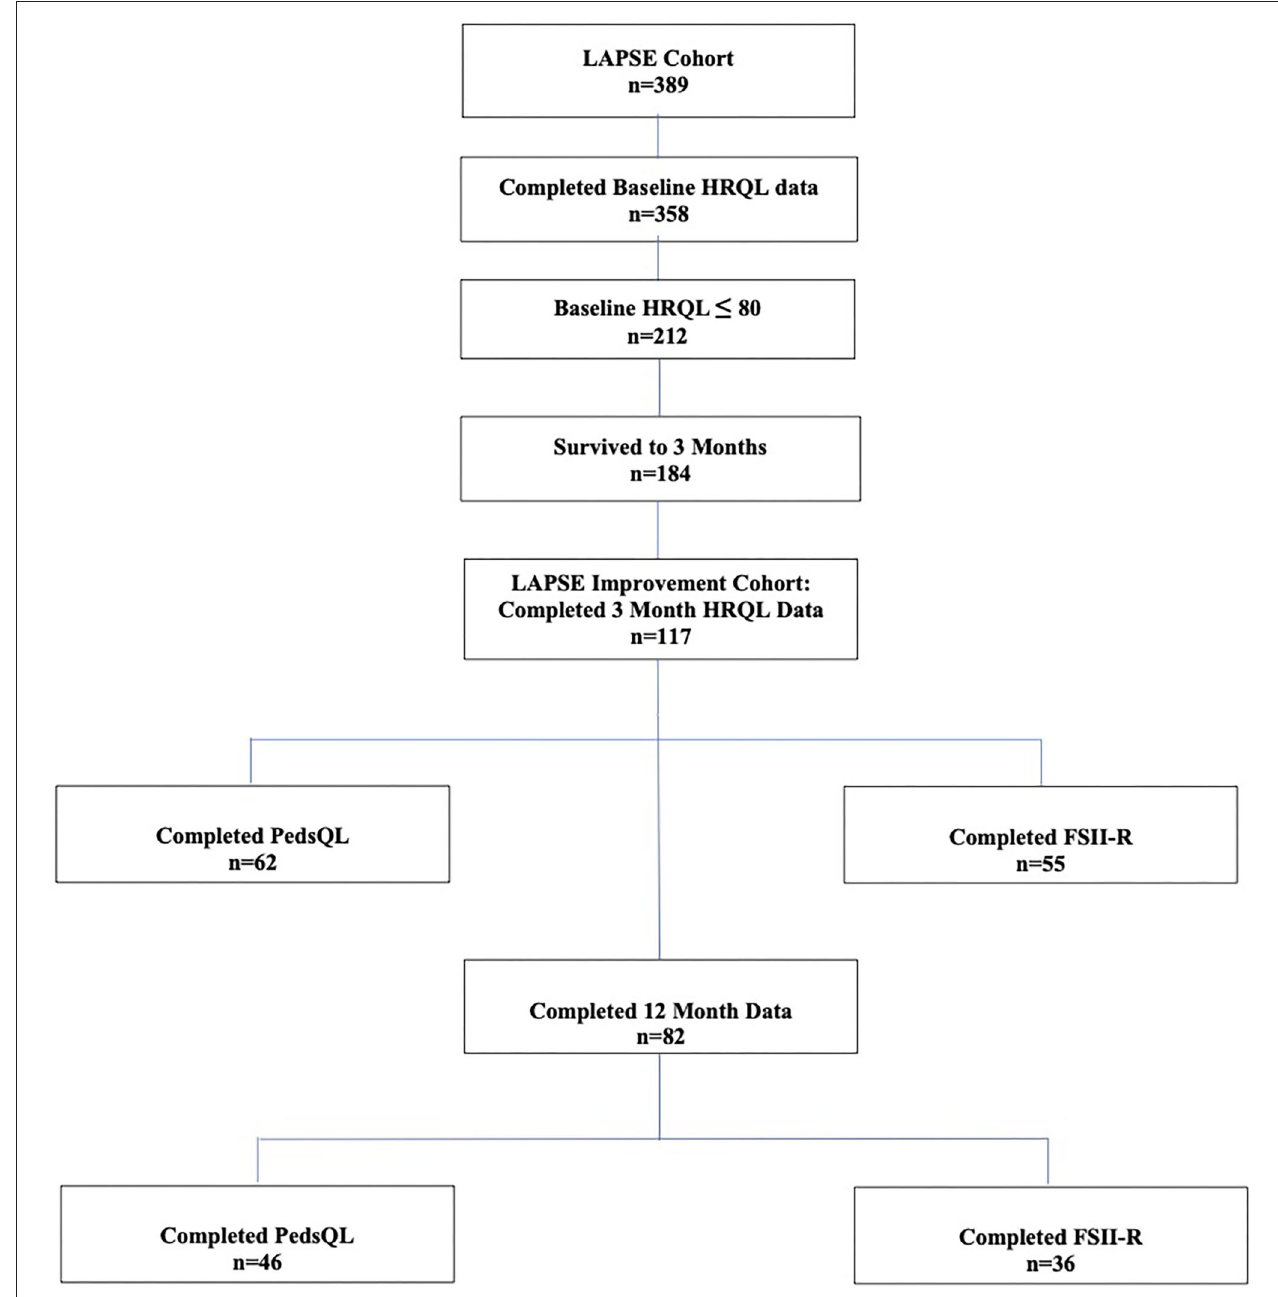
FIGURE 1 | Study Flow